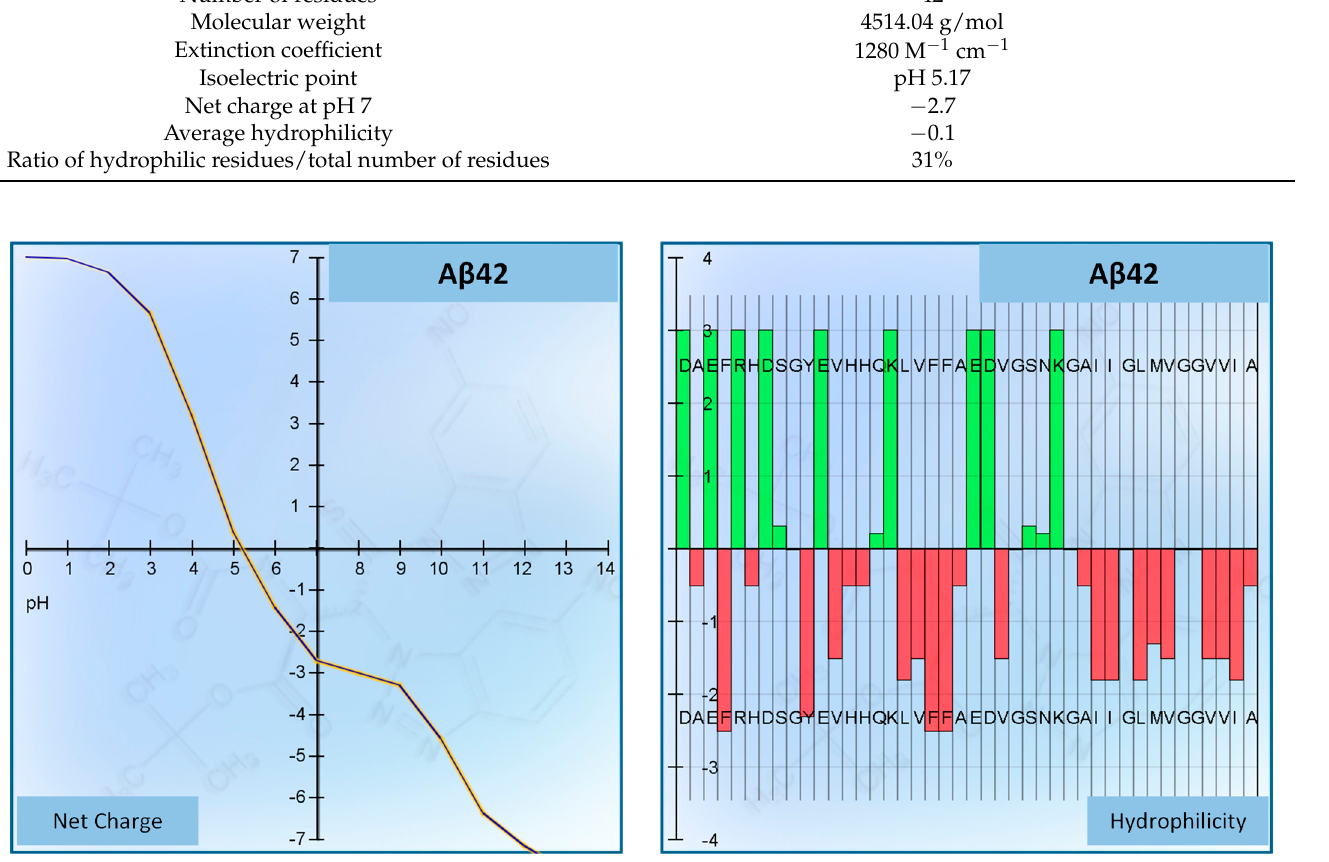
Figure 3. Representation of net charge and hydrophilicity of peptide A β 42 (from Peptide Calcula-